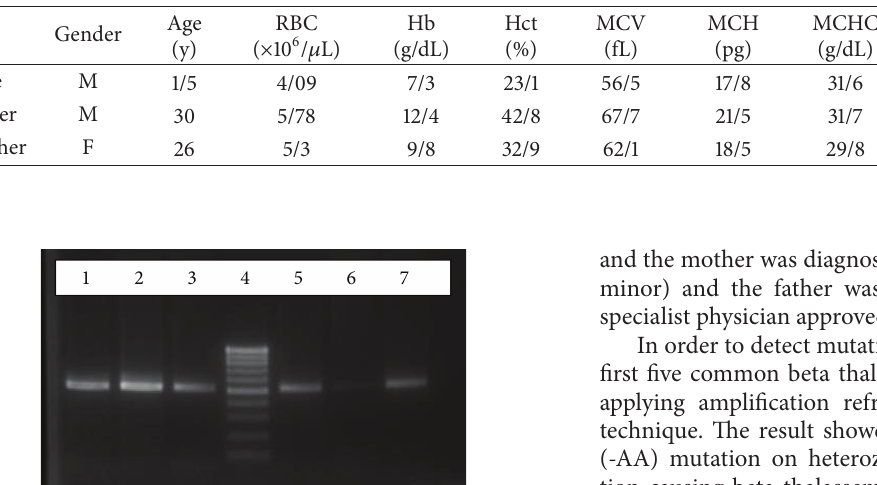
Table 1: Hematological indices of the patient and his parents.